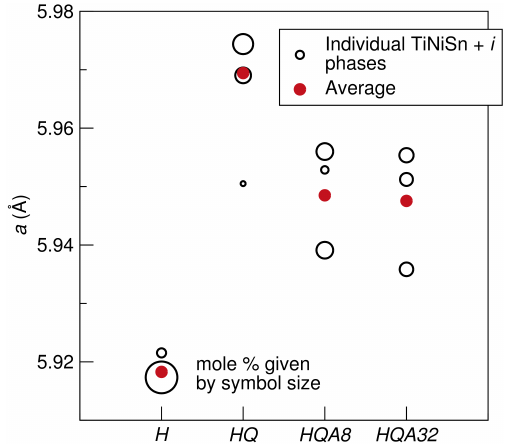
Figure 4. Lattice parameters for each of the half-Heusler phases fit using Rietveld refinement. Symbol size of the open circles corresponds to the mole percent of each contribution. The weighted average lattice parameter of the half-Heusler phases in each sample is given by the red filled circles and is maximized for the HQ sample where the most Ni interstitials are trapped in the half-Heusler structure. Annealed samples have a large range of lattice parameters, and the distribution has shifted to a lower lattice parameter than the HQ